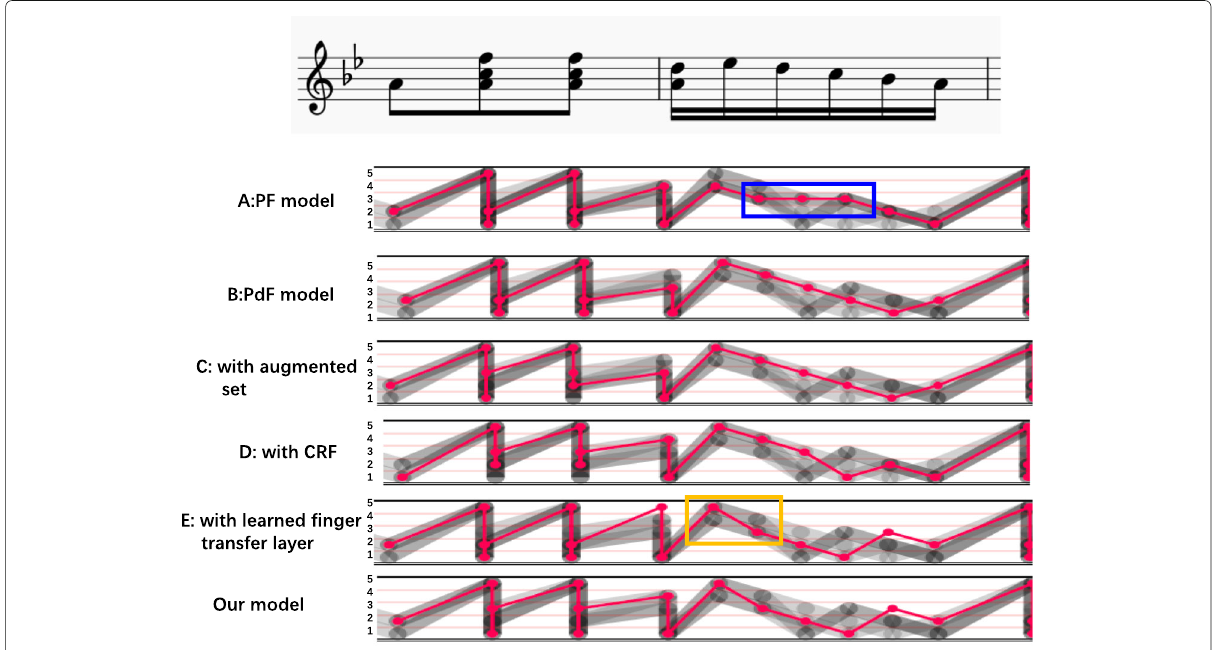
Fig. 8 Comparison of annotation results under a descending scale of the right-hand (English Suite No. 3 – Prelude)